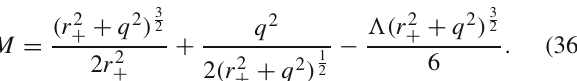
Thesurfacetension σ dependsontheelectriccharge q andthe ( 3 q 6 + 6 q 4 r 2 + + 4 q 2 r 4 + ) l 2 cosmological constant (cid:2) . When r 4 + = − , (cid:2)( q 2 + r 2 + ) 2 ( 3 q 6 + 6 q 4 r 2 + + 4 q 2 r 4 + ) l 2 , the the surface tension is zero, r 4 + > − (cid:2)( q 2 + r 2 + ) 2 surface tension is positive while negative surface tension is ( 3 q 6 + 6 q 4 r 2 + + 4 q 2 r 4 + ) l 2 . The corresponding obtained for r 4 + < − (cid:2)( r 2 Smarr relation is same as Eq.(17). The Gibbs free energy